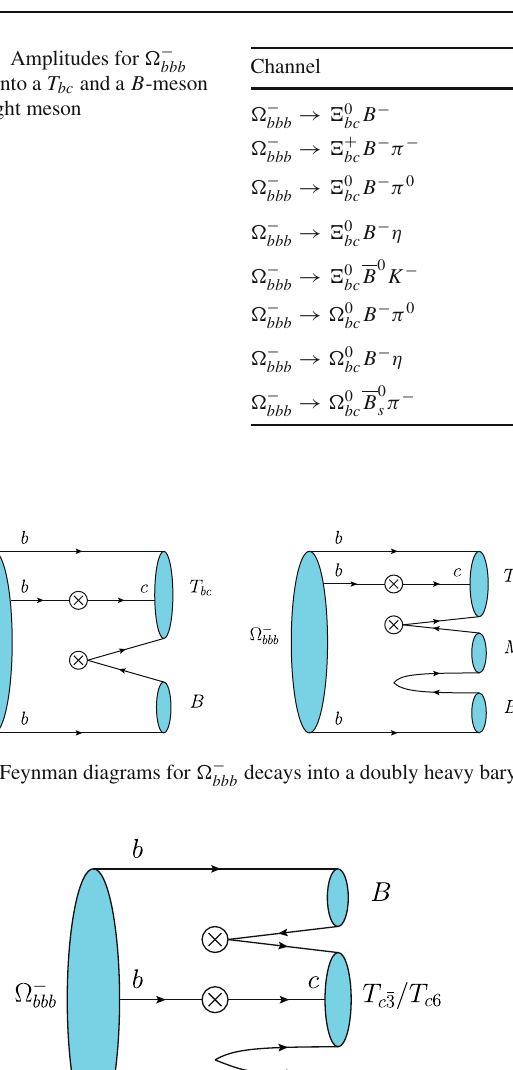
Tree operators can be decomposed in terms of a vector H 3 , and H 15 whose nonzero entries are two traceless tensors H 6